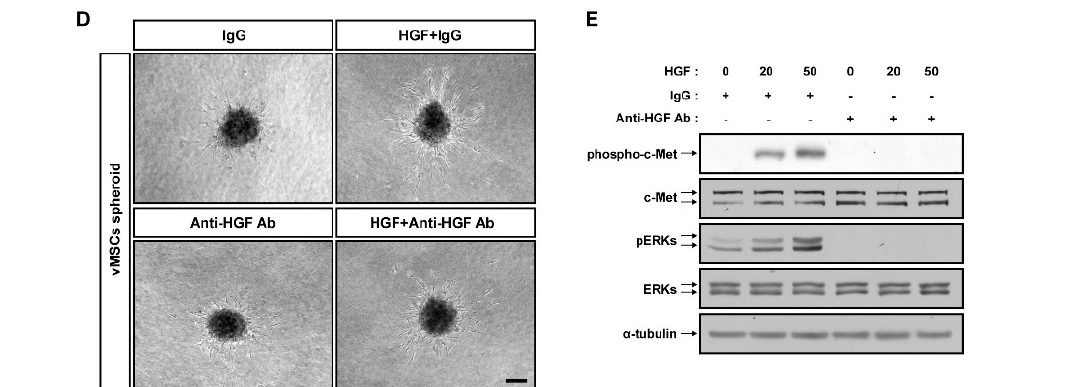
Figure 2. In vitro angiogenic sprouting of vMSCs in response to HGF. ( A , B ) Sprouting capacity of vMSC spheroids incubated with HGF (10, 20, 50 or 100 ng/mL). Representative images are shown in ( B ). ( C , D ) Sprouting capacity of vMSC spheroids treated with HGF (20 ng/mL) and/or HGF neutralizing antibody (anti-HGF Ab, 500 ng/mL) for 48 h. Mouse IgG (IgG, 500 ng/mL) was used as the control. Representative images are shown in ( D ). ( E ) Western blot analysis of phosphorylated c-Met (phospho-c-Met), c-Met, phosphorylated ERKs (pERKs), and ERKs in vMSCs treated with HGF (20 ng/mL or 50 ng/mL) and/or HGF neutralizing antibody (anti-HGF Ab, 500 ng/mL) for 5 min. Mouse IgG (IgG, 500 ng/mL) was used as the control. α -Tubulin was used as an internal control. Results are presented as the mean ± SD. n.s.; not significant. Scale bar; 100 μ m. Uncropped Western blot images are shown in figure S2.